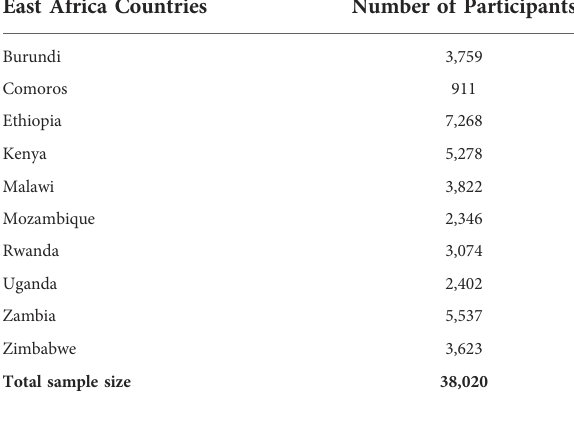
TABLE 1 The study participants of infertility and undernutrition in East African countries. East Africa